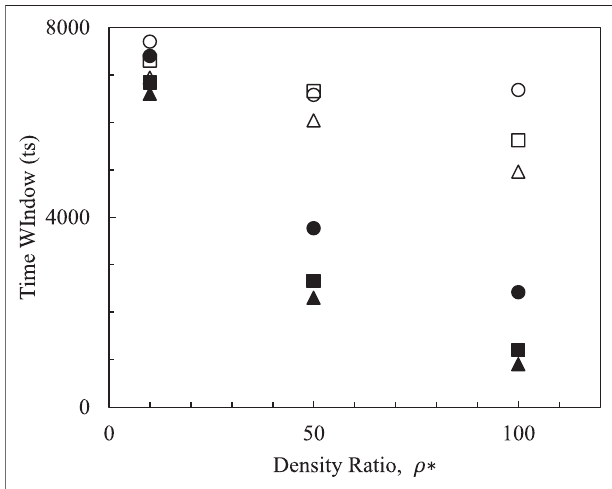
FIGURE 6 | Effects of density ratio ρ * on time windows: solid symbols represent large droplets ( R (cid:1) 25 lu) and empty symbols stand for small droplets ( R (cid:1) 15 lu), respectively; circles ( σ (cid:1) 1 × 10 − 4 mu/ts 2 ), squares ( σ (cid:1) 2 × 10 − 4 mu/ts 2 ) and triangles ( σ (cid:1) 2.5 × 10 − 4 mu/ts 2 ) represent three speci fi ed surface tensions coef fi cients,